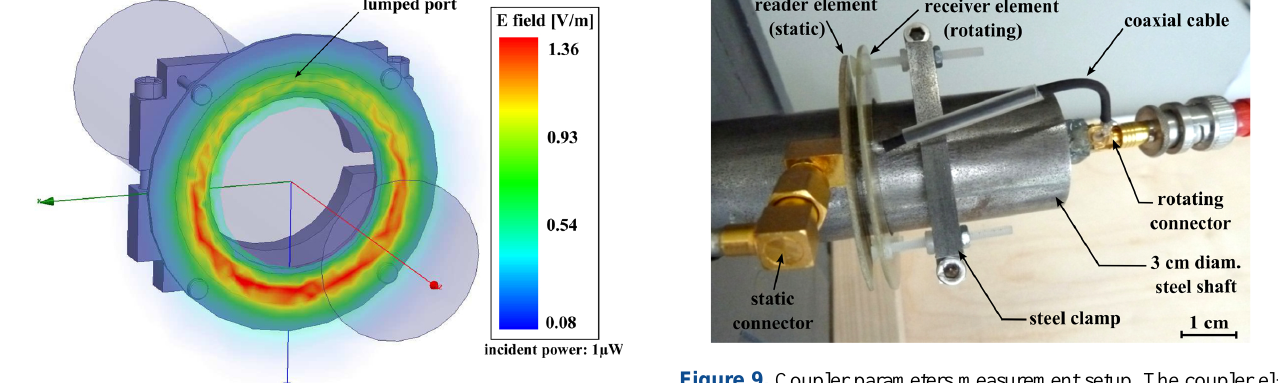
Figure 9. Coupler parameters measurement setup. The coupler el- ements are connected to the network analyzer using calibrated ca- bles.